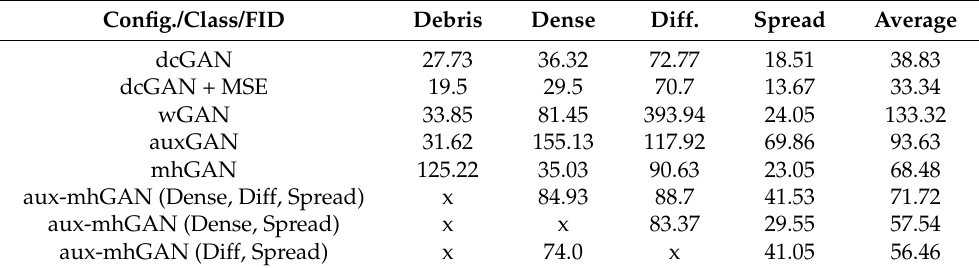
Table 7. Frécet inception distance (FID) scores for each GAN configuration by image class. An x indicates where the GAN was not trained to generate the specific image class.